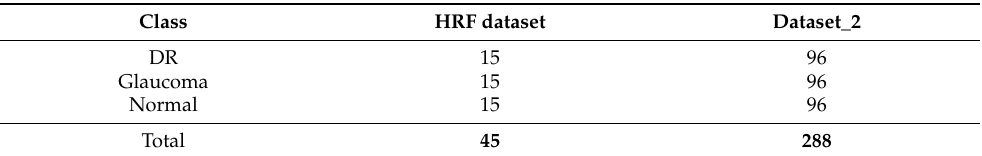
Table 2. Number of images in each dataset.